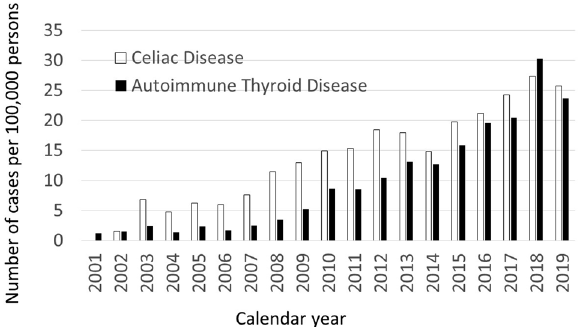
Figure 1. Prevalence of celiac disease and autoimmune thyroid disease in the cohort per 100,000 persons enrolled, by calendar